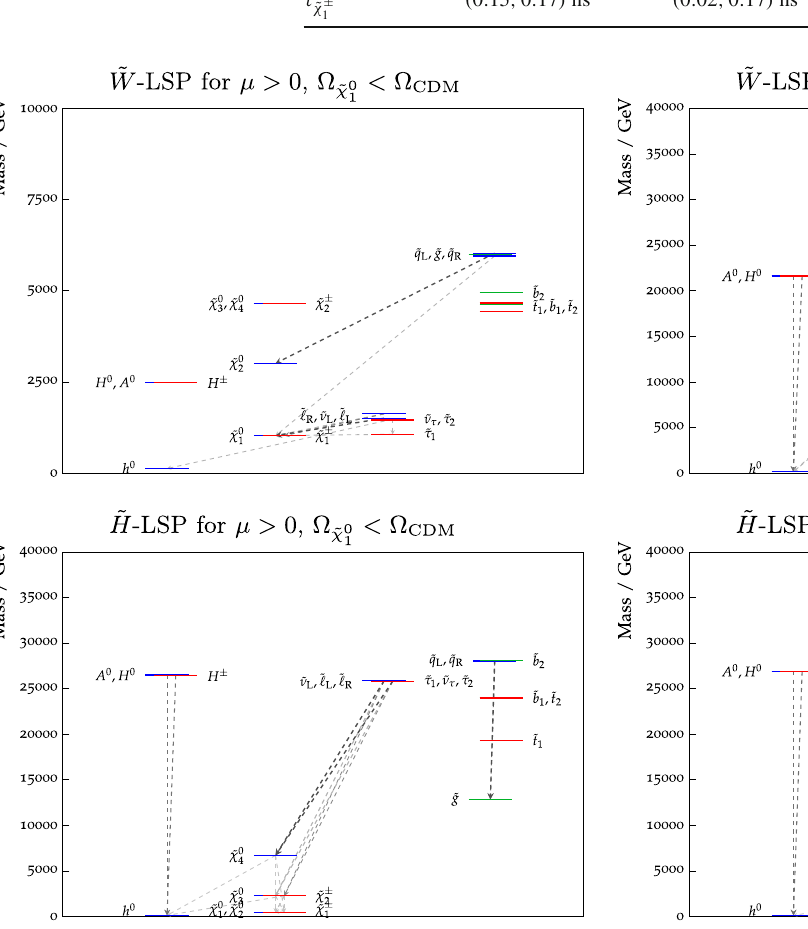
shading for larger BRs, and the colours of the horizontal bars reflect particles electric charges. The range of masses shown for the ˜ W -LSP μ > 0 best-fit point ( top-left panel ) is smaller than the others, since its mass spectrum is considerably lighter